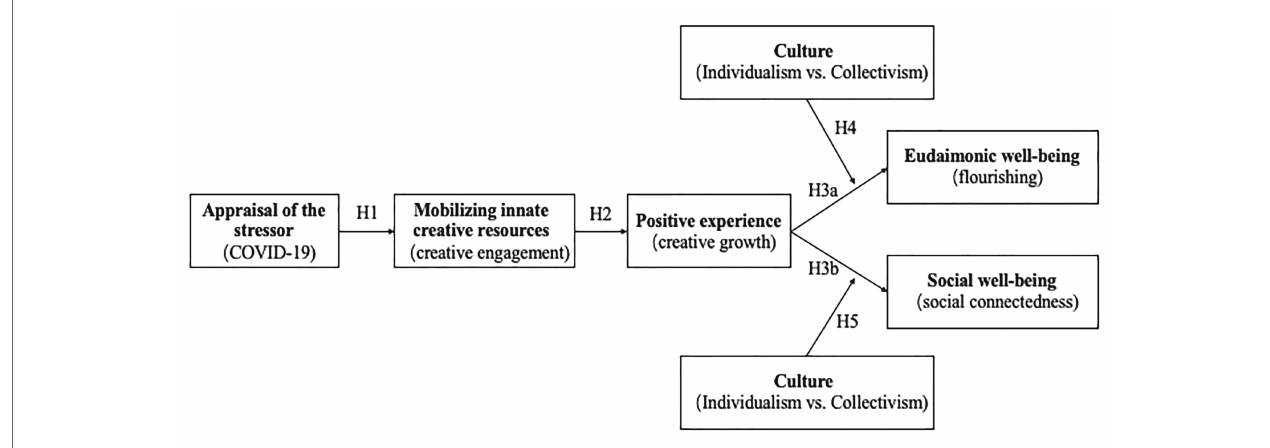
FIGURE 1 | Theoretical model of the study: the culturally moderated mediating model of creativity on well-being and social connectedness